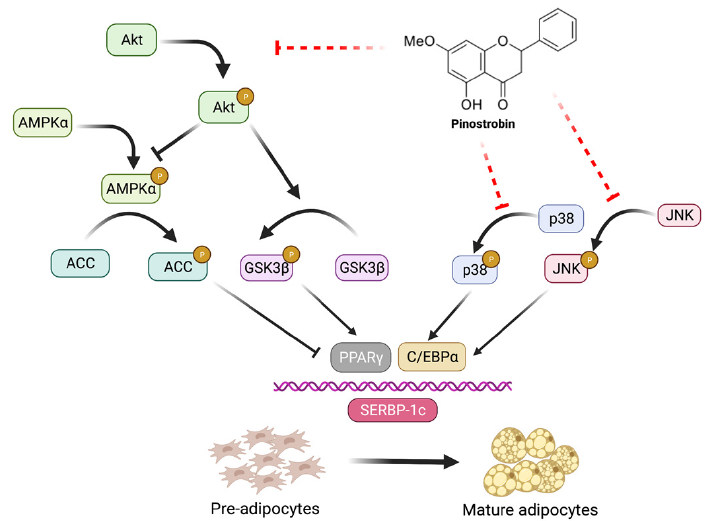
Figure 9. Proposed regulatory mechanisms of pinostrobin on the suppression of adipogenesis. The diminution of cellular lipid droplets and adipogenic transcription factors (PPAR γ , C/EBP α , and SREBP-1c) in pinostrobin-treated adipocytes might be mediated through modulating Akt (Akt/GSK3 β and Akt/AMPK-ACC) and MAPK (JNK and p38) signals. This figure was created with BioRender.com.